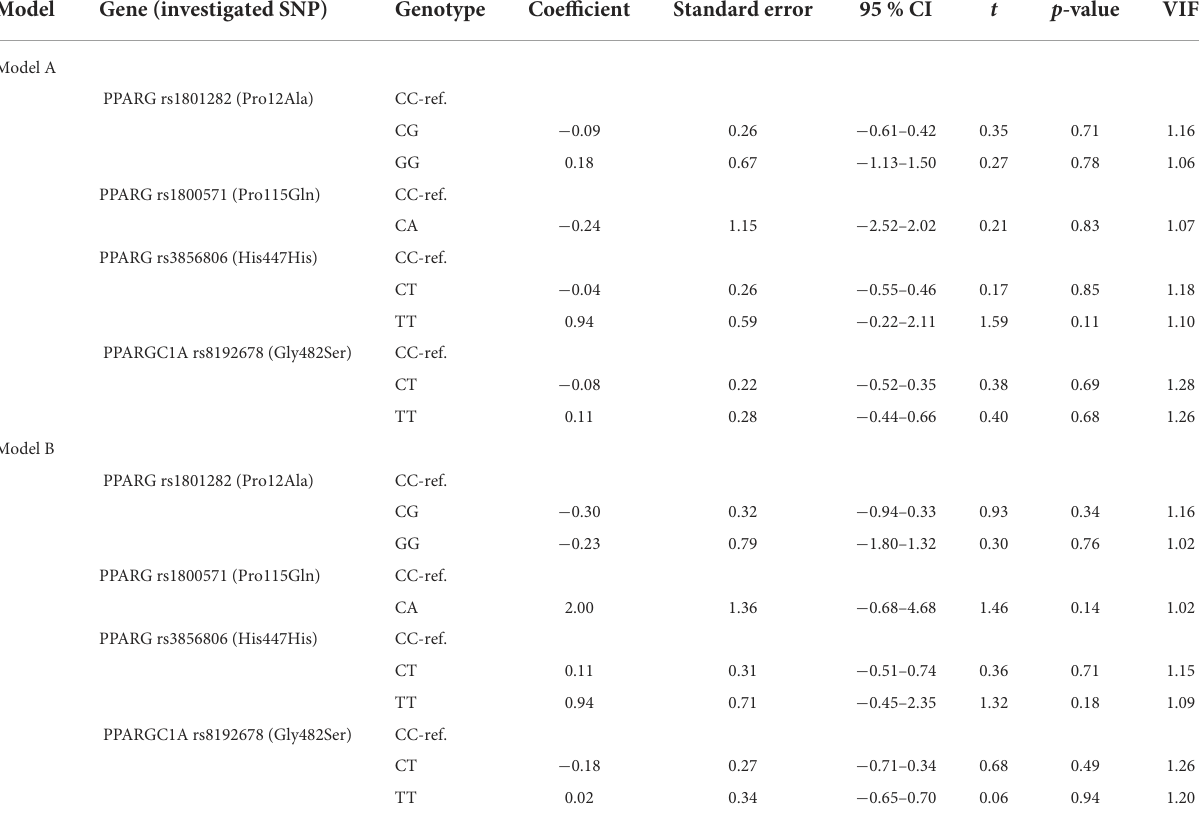
TABLE 4 Multiple linear regression for association between genotype frequency and patients’ BMI, after adjustment for parental confounders using two